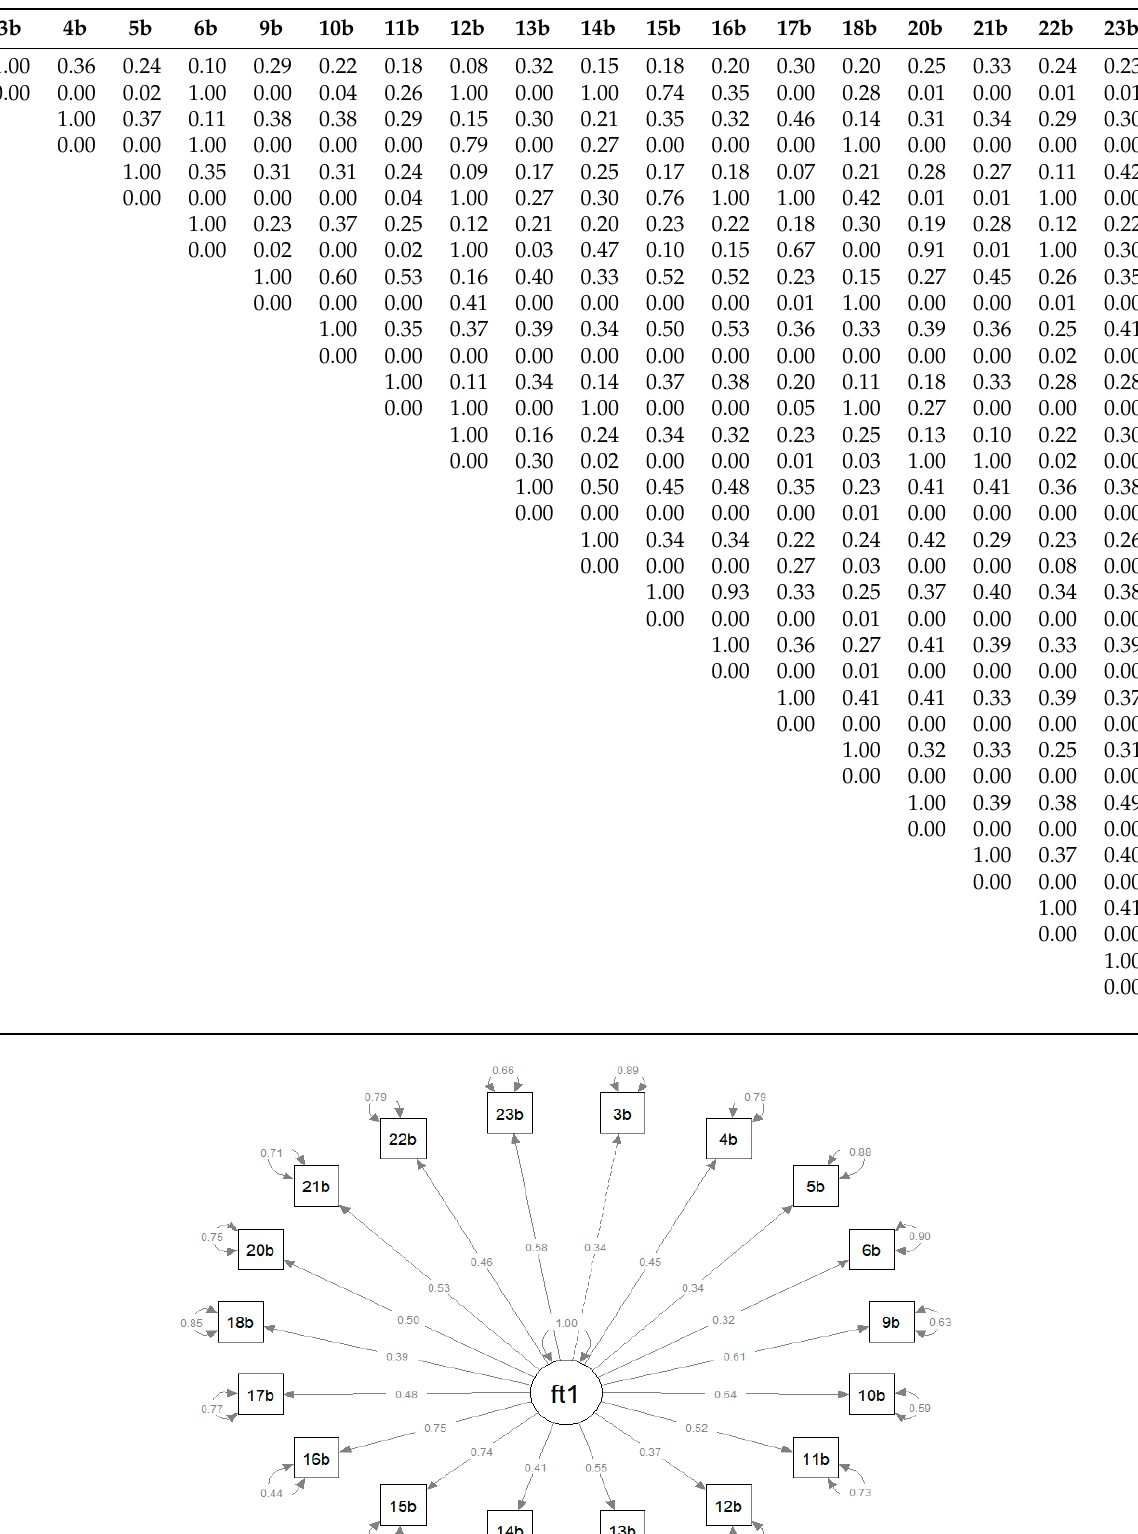
Table 4. Spearman’s inter-item and item-total correlations.